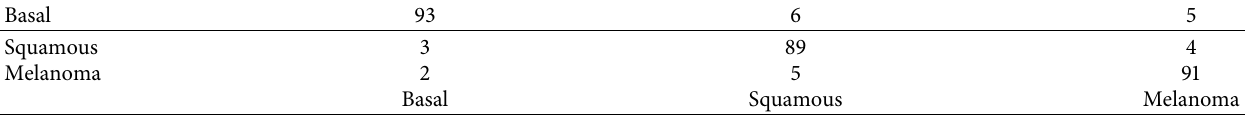
Table 4: The recognition rate of proposed method for three types of melanoma.